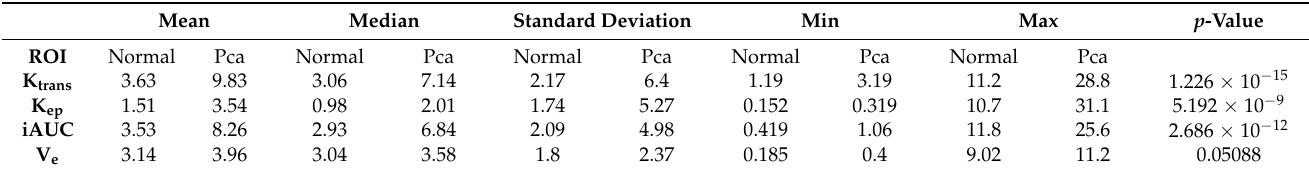
Table 2. Quantitative pharmacokinetic parameters in carcinoma-to-muscle ratio and normal tissue- to-muscle ratio.